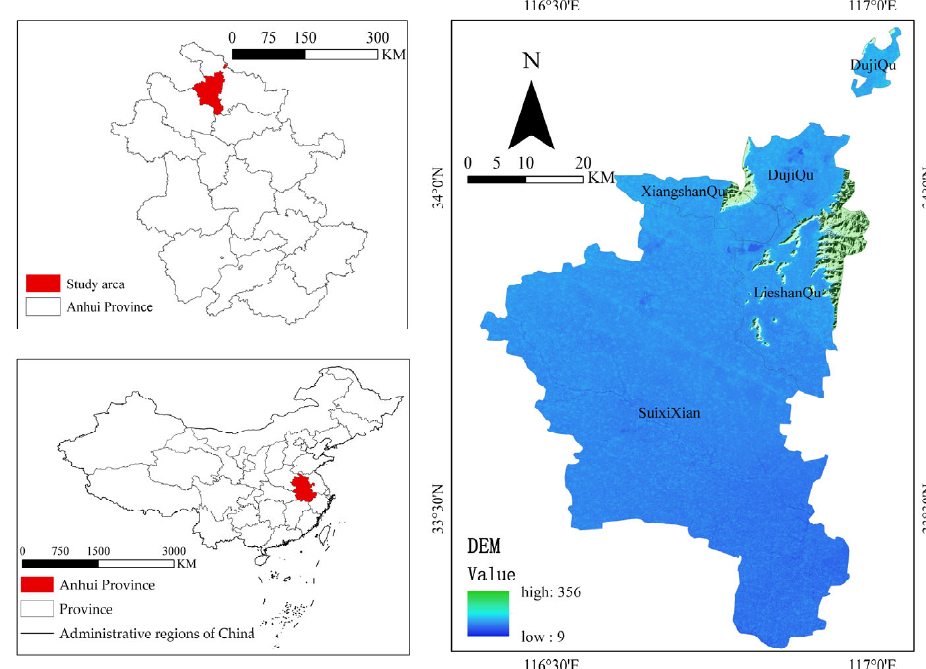
Figure 1. Location of the study area.